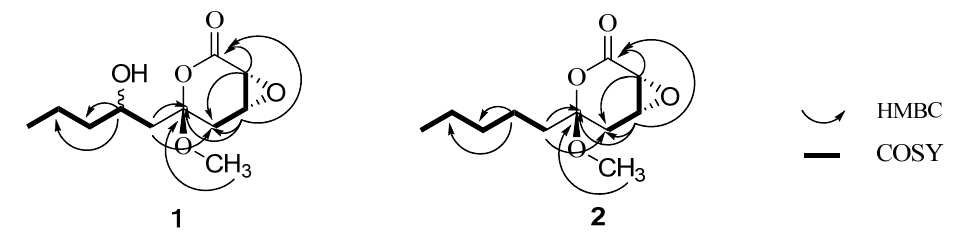
Figure 2. Selected HMBC and 1 H- 1 H COSY correlations of pestalrone A ( 1 ) and pestalrone B ( 2